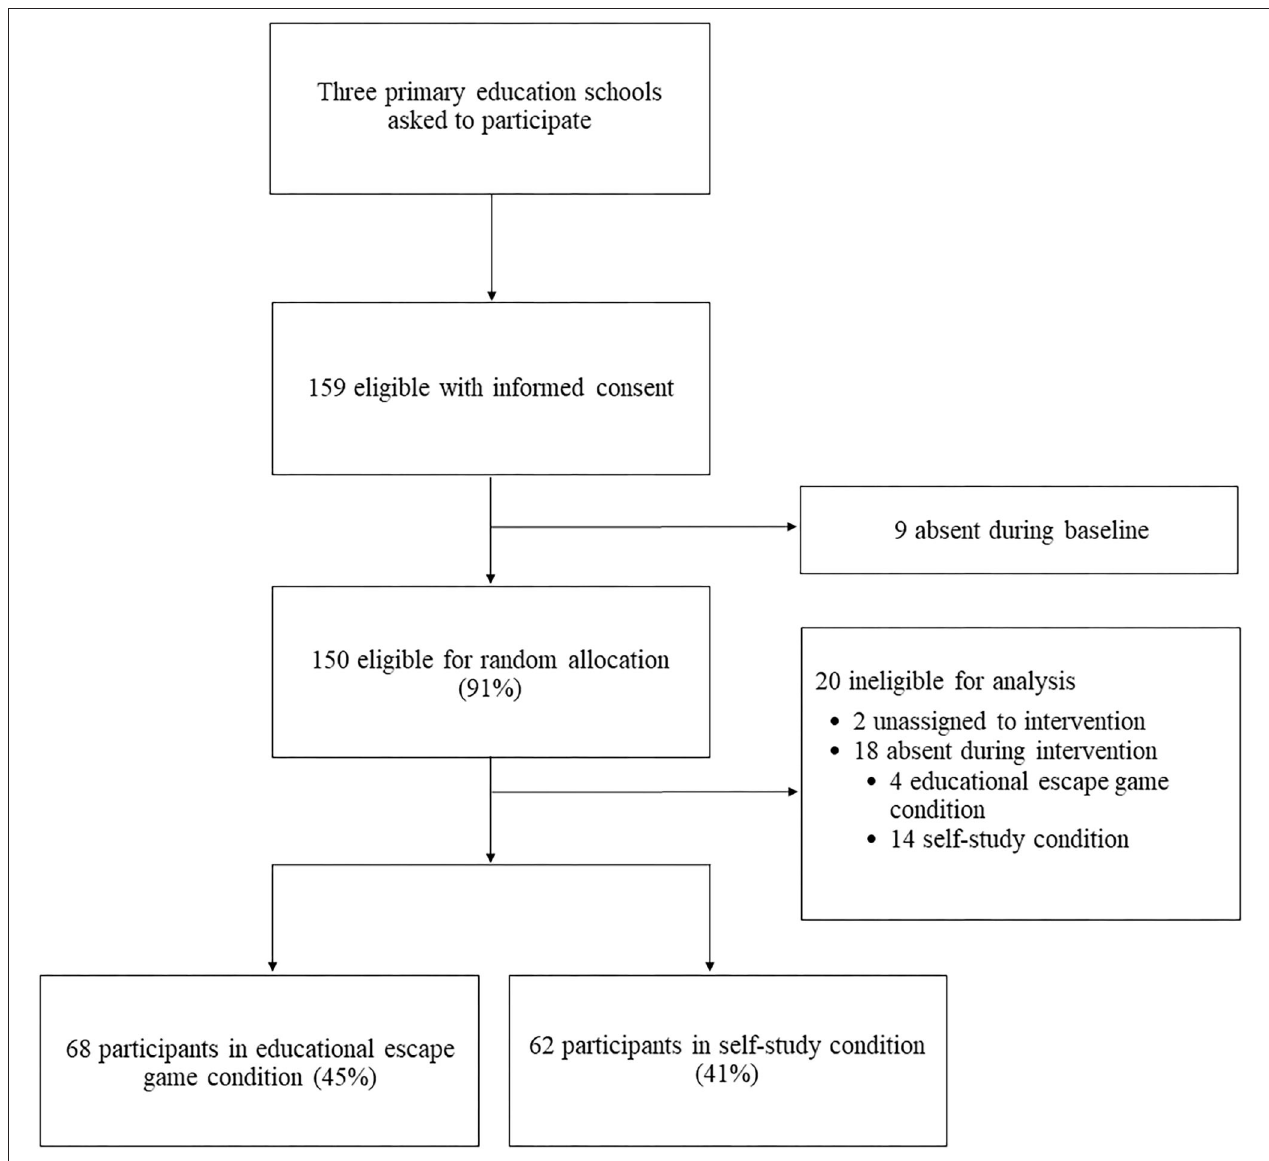
FIGURE 1 | Flow diagram of study